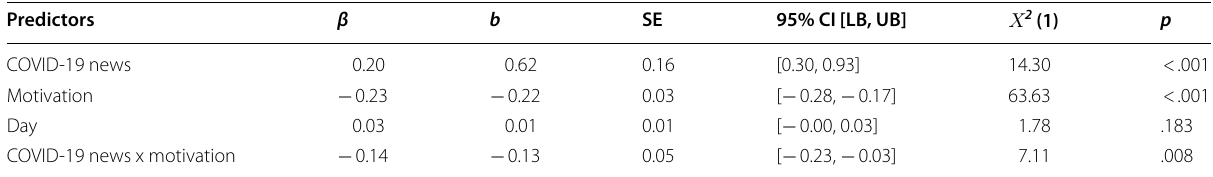
Note Rows present the effects of predictors on ratings of TUT (task-unrelated thought, 1 included COVID-19 news (COVID-19-related news consumption, no COVID-19 news consumption as the reference category), task motivation (1 to 5 extremely motivated), and day (day-in-study from 1 to 10). The model also included a random effect of participant on the intercept. Analysis of variances was = tested through Type III Wald chi-square tests. Model residuals passed assumptions of normality and homogeneity of variance β standardized parameter, b unstandardized parameter, SE standard error of the estimate, 95% CI 95% confidence interval associated with the unstandardized parameter, UB upper bound, LB lower bound. Χ 2 (1) chi-squared test statistic associated with comparison between the current model and a null model without the predictor of interest (1 degree of freedom), p p-value associated with the chi-squared test